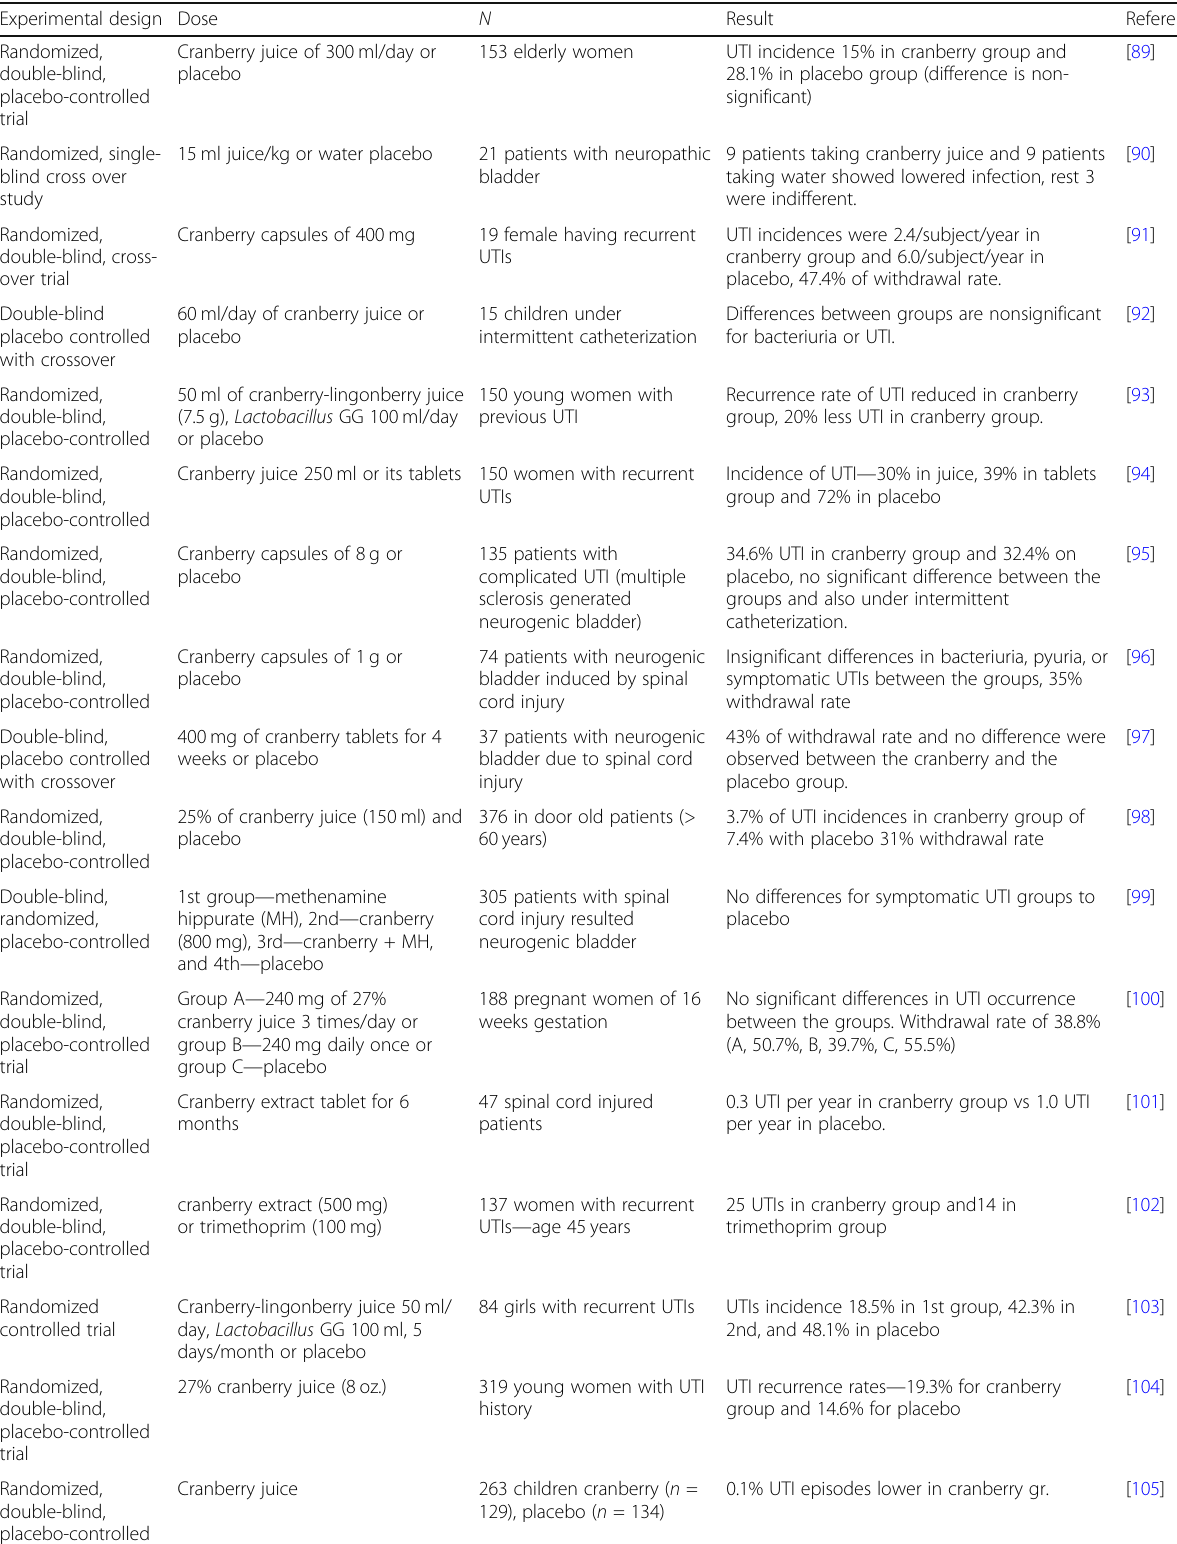
Table 4 Clinical trials of cranberry products for UTI prevention in different populations Experimental design